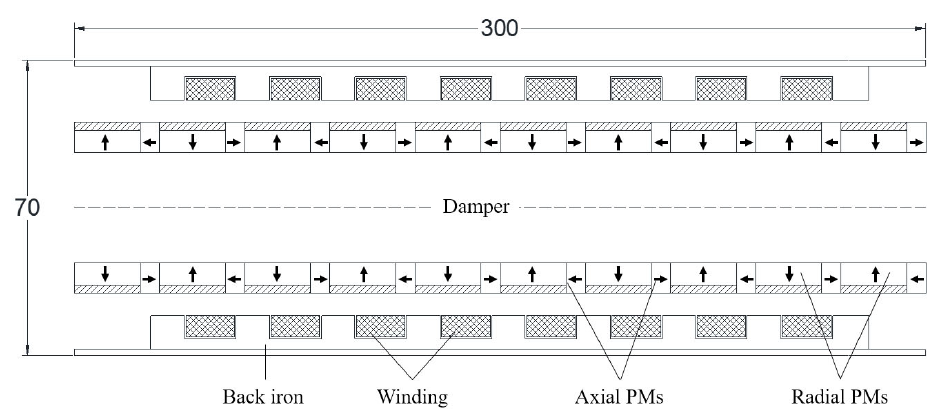
Figure 2. Configuration of the eight ‐ slot eight ‐ pole electromagnetic shock absorber.